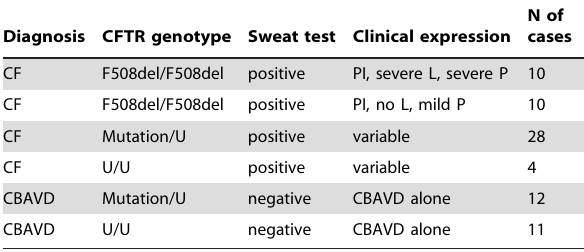
Table 1. Main features of patients under